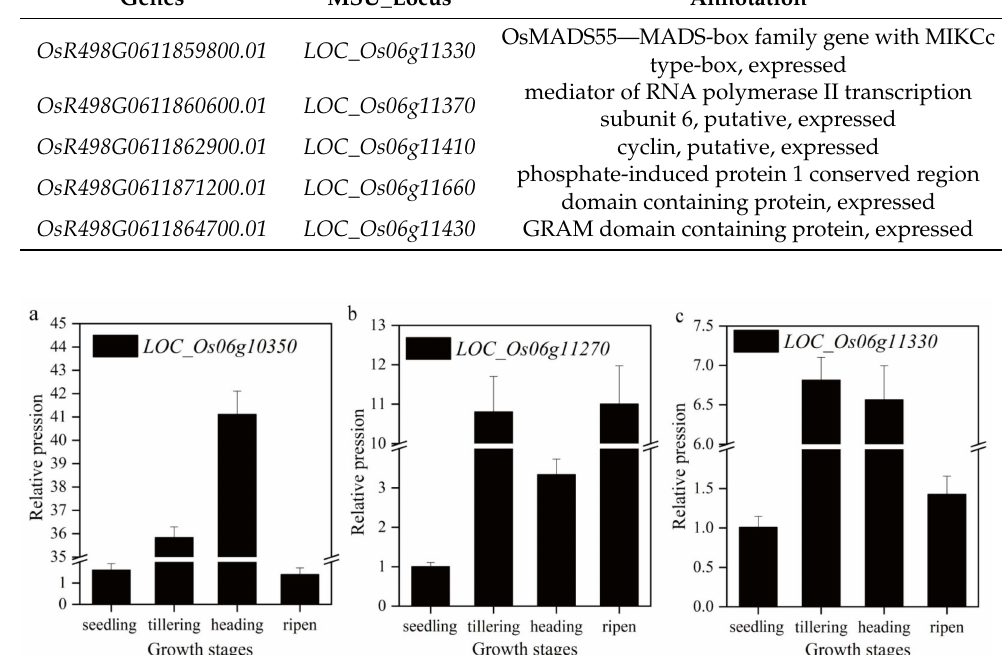
Figure 3. The transcript levels of the three candidate genes at the four growth stages of H93S. ( a ), LOC_Os06g10350 . ( b ), LOC_Os06g1035011270 . ( c ), LOC_Os06g11330